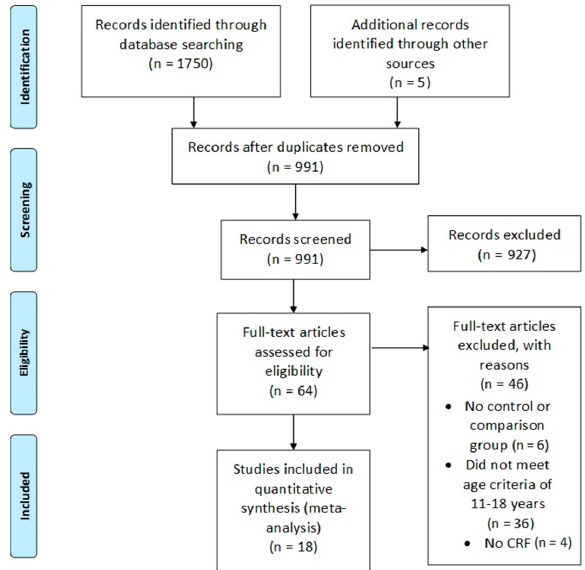
Figure 1. Preferred Reporting Items for Systematic Reviews and Meta-Analyses (PRISMA) flow diagram to show each stage of the systematic eligibility process. Note: CRF = Cardiorespiratory Fitness.